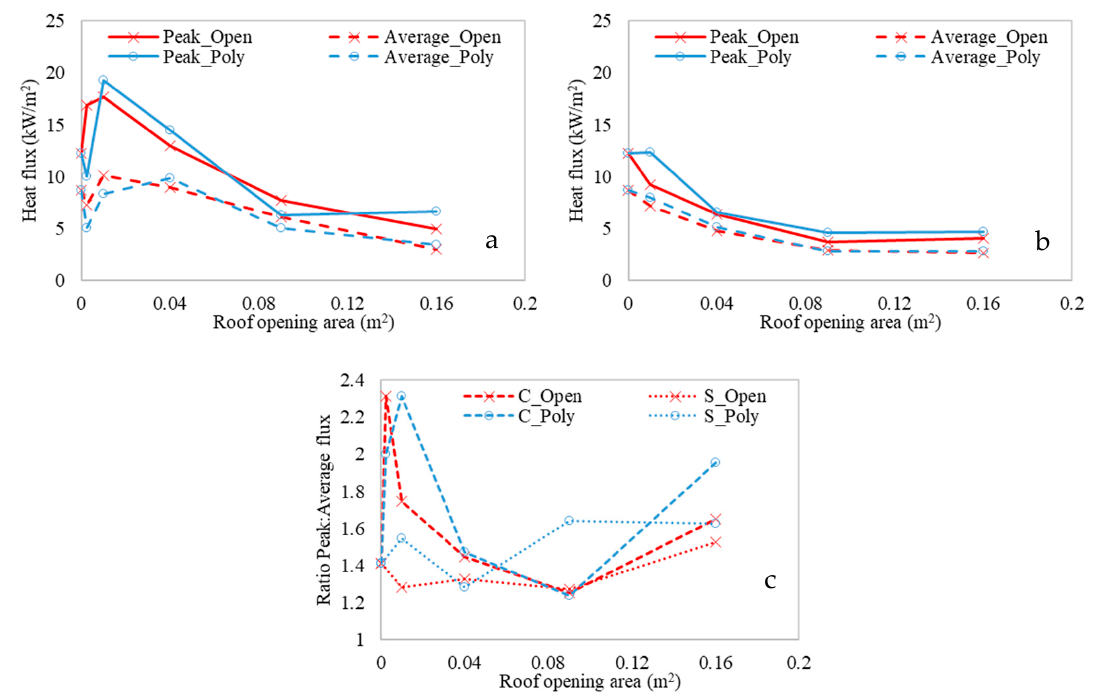
Figure 14. Peak and average heat fluxes in the steady-state, 30 cm from the door for ( a ) corner and ( b ) slot opening cases, and ( c ) the ratio between peak and average flux in each case.